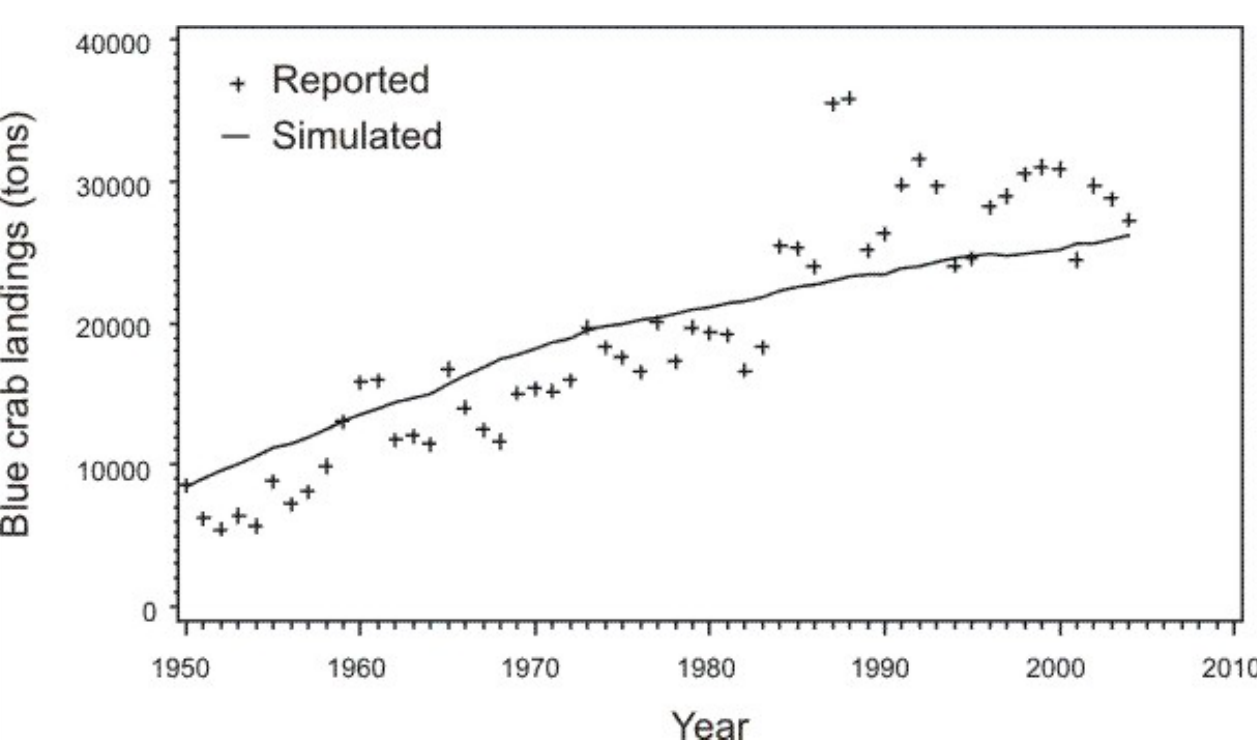
Fig. 7. Model hindcast simulation of Gulf of Mexico blue crab